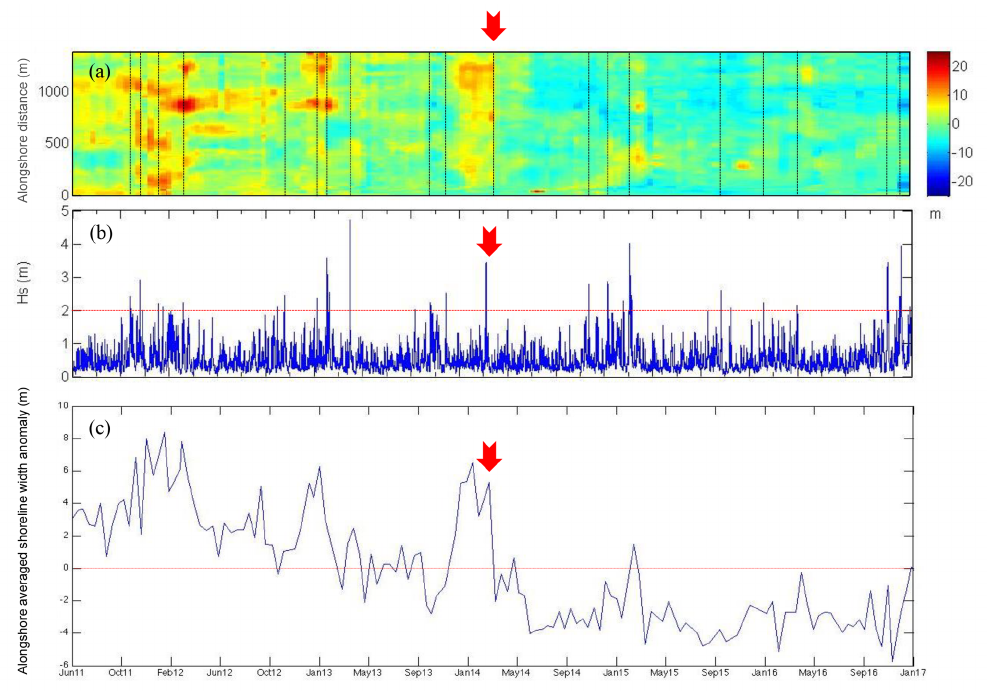
Figure 2. (a) Alongshore shoreline width anomaly at Cala Millor from November 2010 to January 2017. Red colors indicate shoreline advance, whereas blue ones indicate shoreline recession. The dashed black lines show the sea storm events larger than 2m. (b) Wave significant height from a wave recorder located at − 17m in the middle of the Cala Millor embayment. (c) Alongshore averaged shoreline width anomaly at Cala Millor. The red arrows highlight the storm group event at April